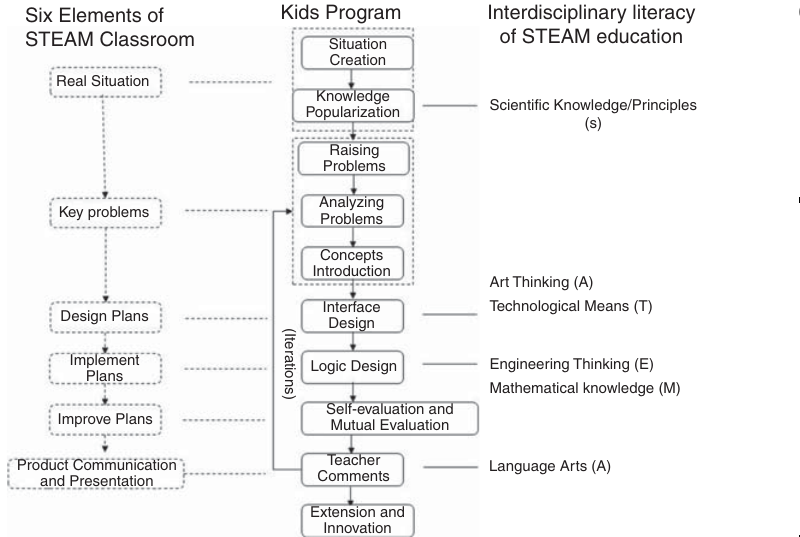
Figure 1. The general